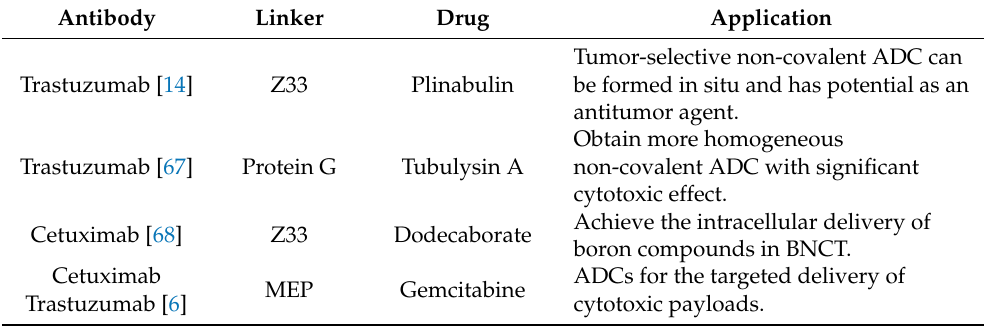
Table 3. Non-covalent antibody–drug conjugates by different linkers and their applications. Antibody